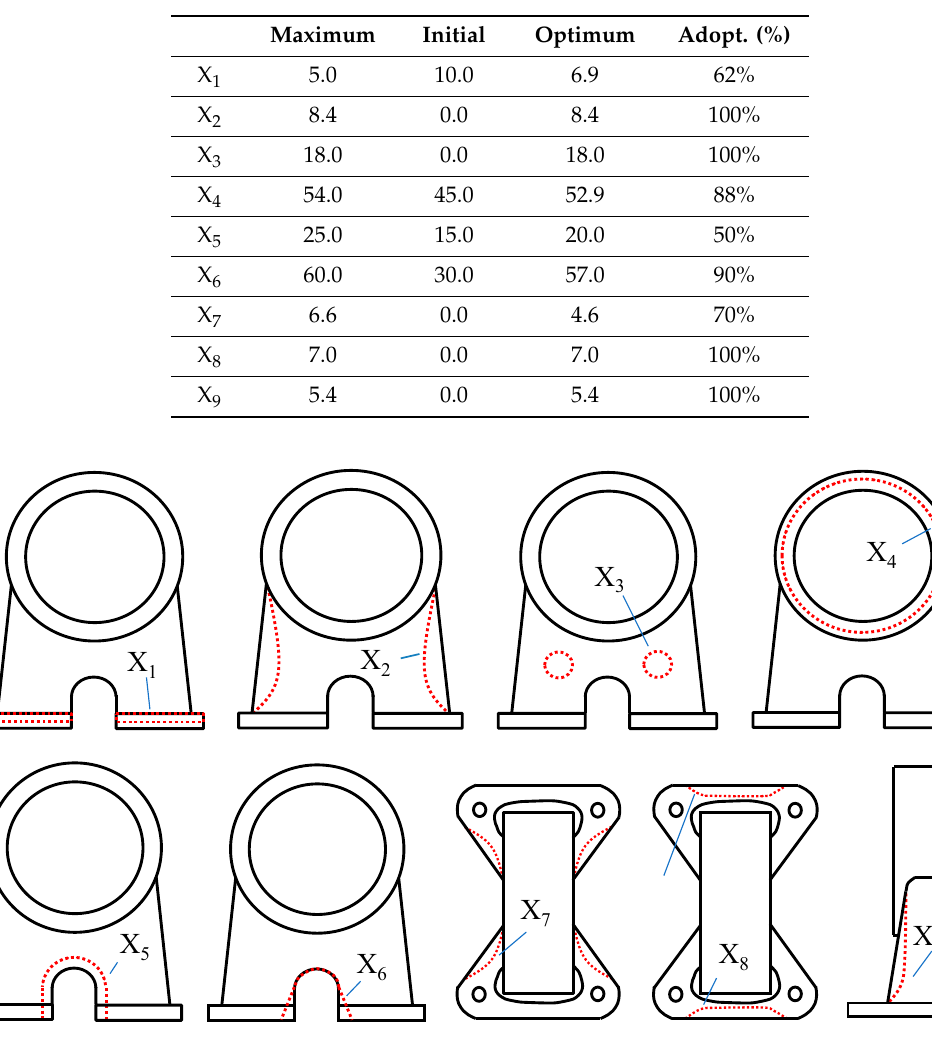
Table 2. Change of design variables (mm).